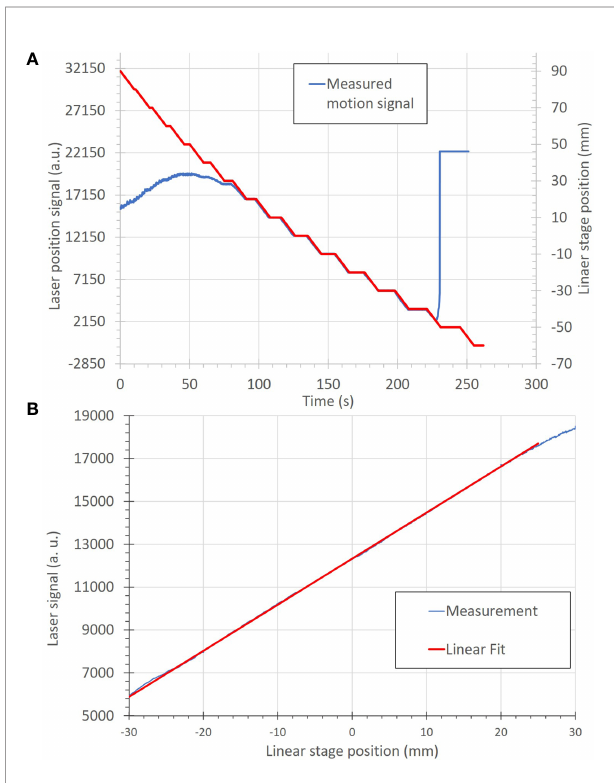
FIGURE 6 | (A) Correlation of motion position to the measured signal of the motion-monitoring device (an optical distance laser sensor) for a step-wise motion pattern. The motion positions, in mm, (red) are uploaded onto the linear stage as a motion fi le and used to move the linear stage. The motion- monitoring device then records the relative displacement (blue) as an analog signal. The left and right portions of the motion signal show where the motion-monitoring device is out of signal range. (B) A plot of position accuracy between the optical distance laser signal (in arbitrary units) and the linear stage position (in